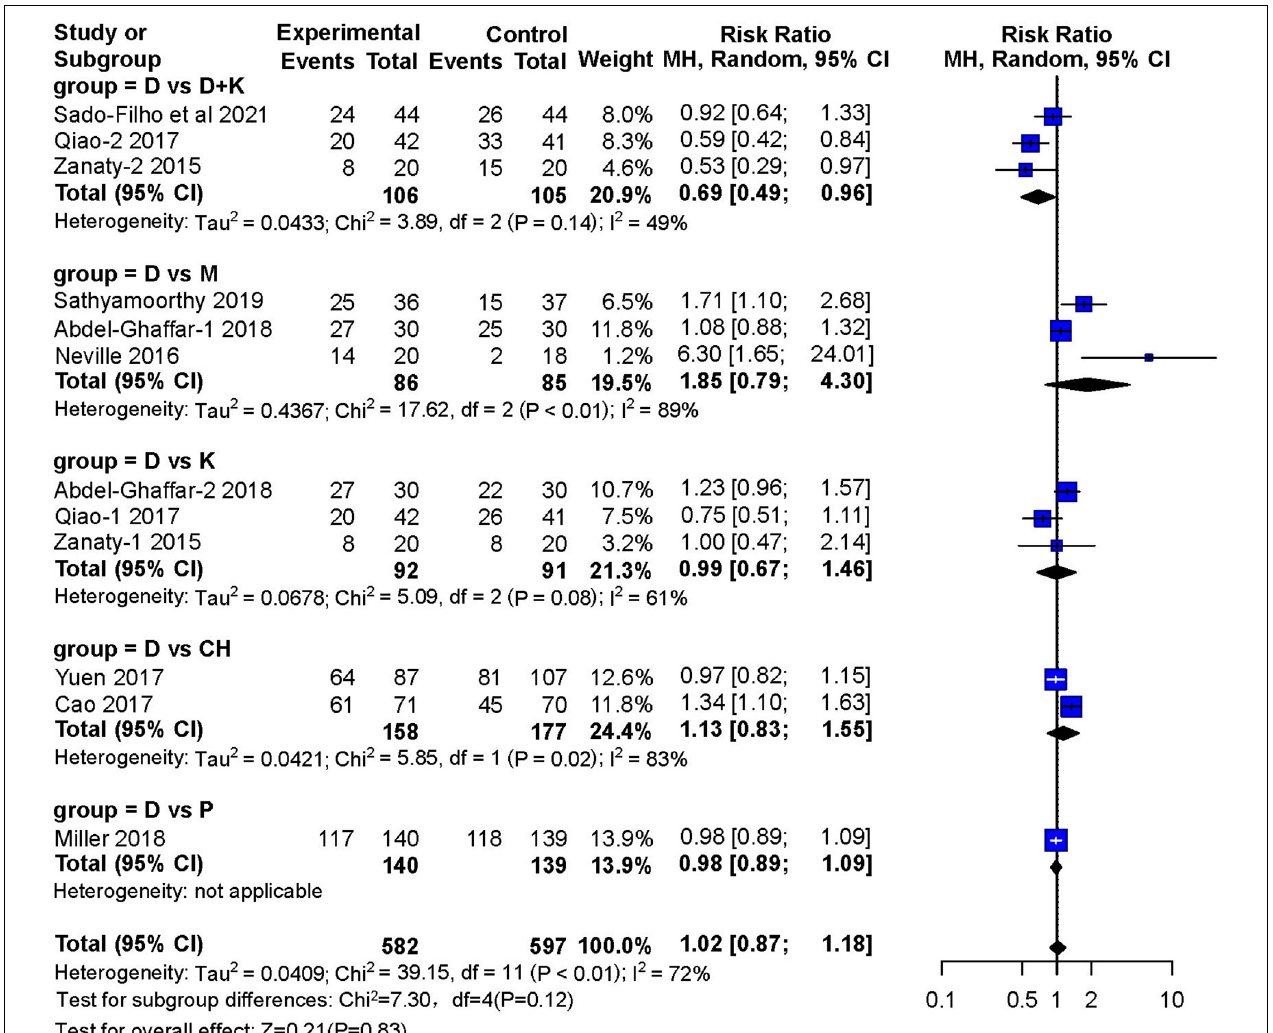
FIGURE 4 | Meta-analysis of nebulized dexmedetomidine for sedation satisfaction.CI, confidence interval; df, degress of freedom; M-H,